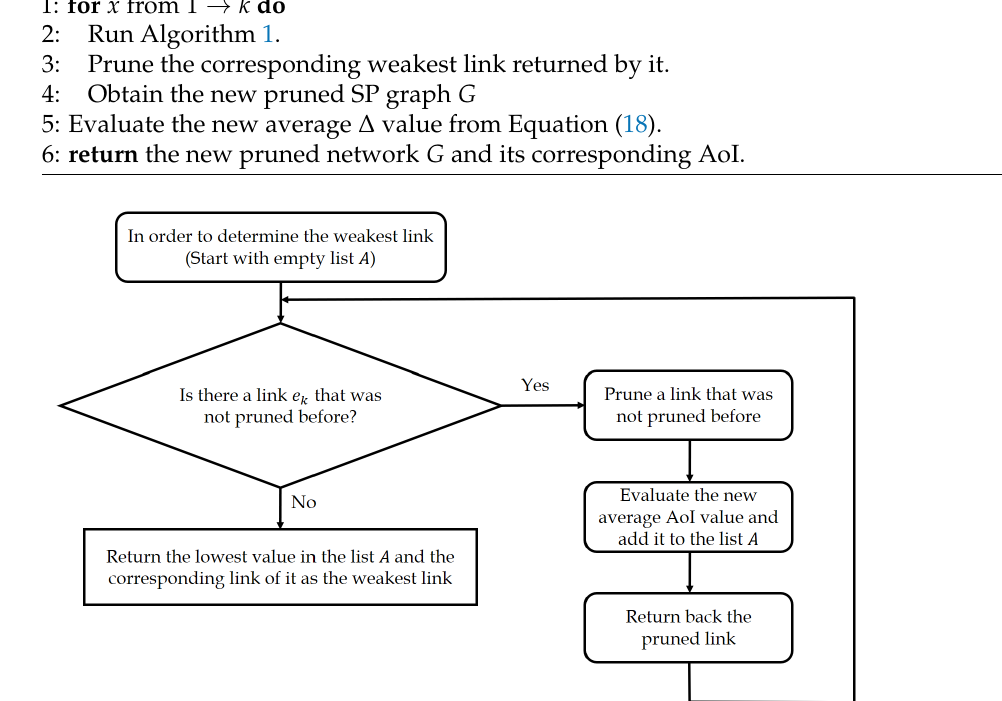
Figure 5. Flowchart showing the process of determining the weakest link in the probabilistic